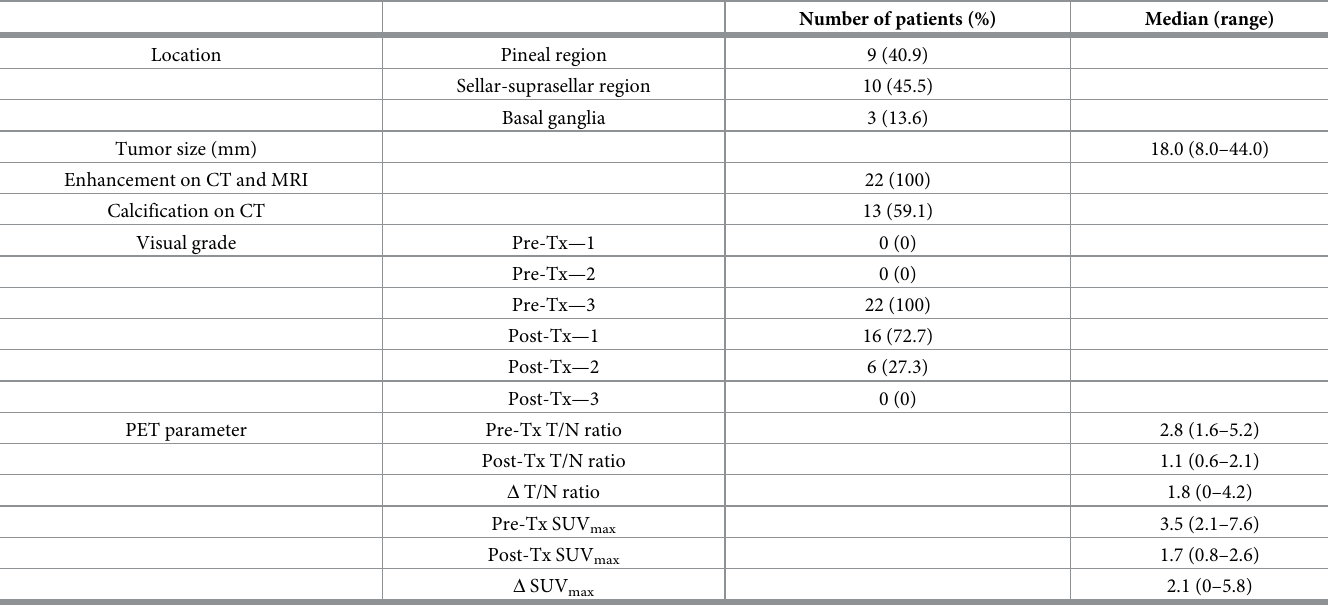
Table 2. Characteristics of 22 pathologically confirmed